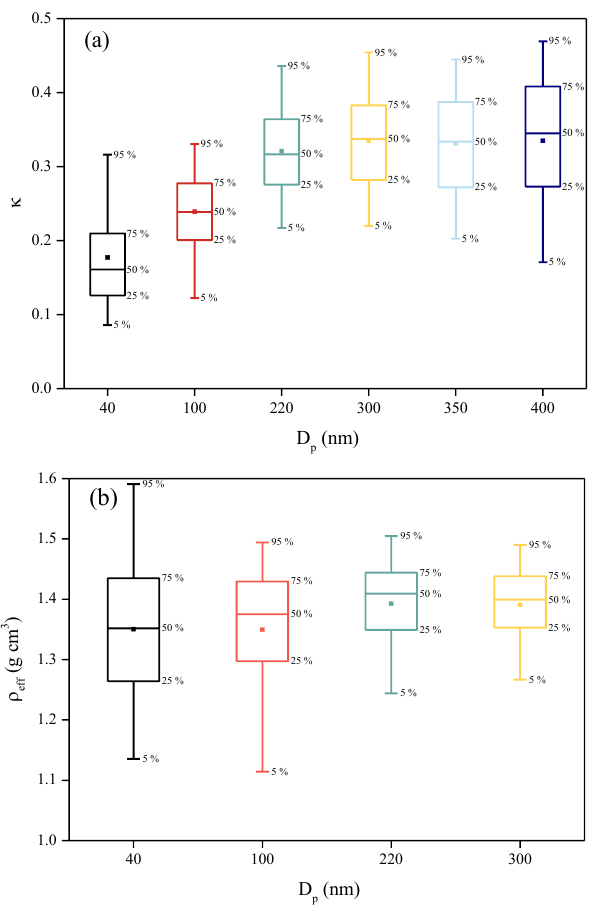
Figure 4. Box plots showing hygroscopicity parameter and effec- tive density at each dry diameter over the whole observation. The whiskers represent the 5th and 95th percentile, the two borders of box display the 25th and 75th percentile, and the band in each box denotes the